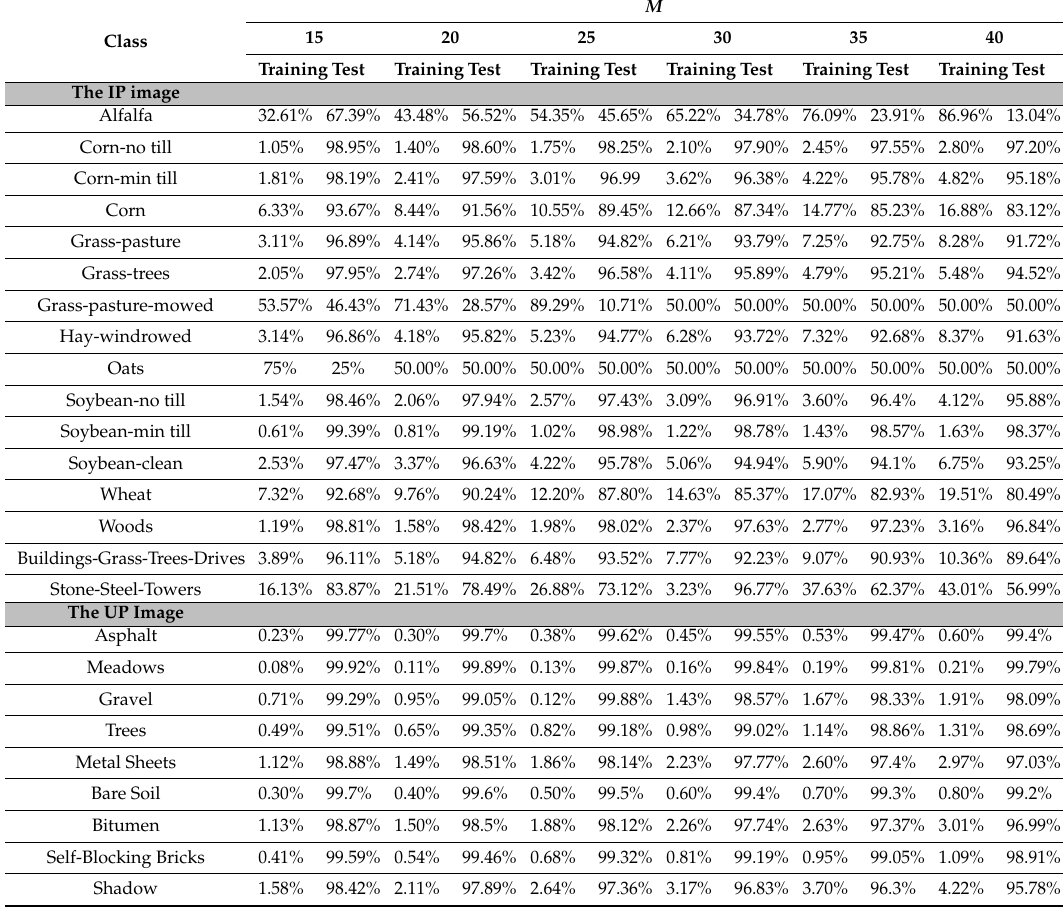
Table 1. The percentage of the total pixels used as training and test for the IP and UP images under different values of M